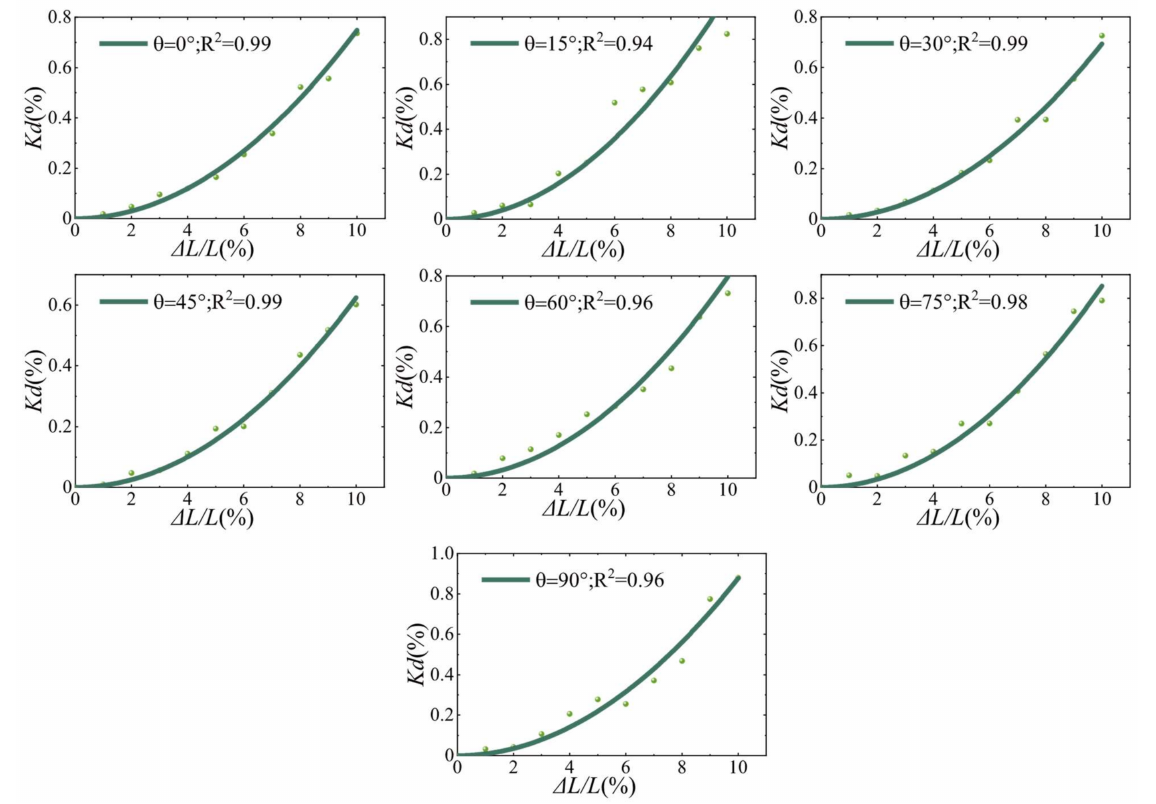
Figure 8. Correspondence between observed values of decorrelation coefficient ( Kd ) and crack length change. For each model with an angle θ , eleven numerical models with different crack lengths were used.